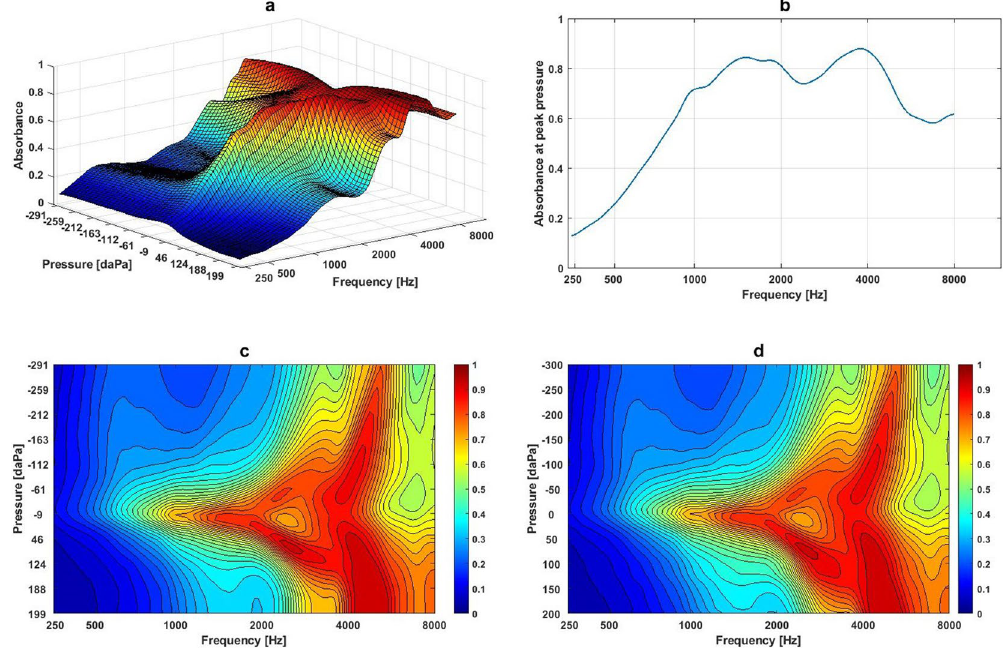
Figure 1. An example of the 3D WAI image and data pre-processing: ( a ) An example of 3D WAI data obtained from a participant with normal middle ear function aged 22; ( b ) the 2D frequency-absorbance plot at the peak pressure obtained from same participant; ( c ) the 2D frequency-pressure image converted from the 3D WAI in Fig. 1a; ( d ) the 2D frequency-pressure image converted from the 3D WAI in ( a ) after interpolating the pressure values on the